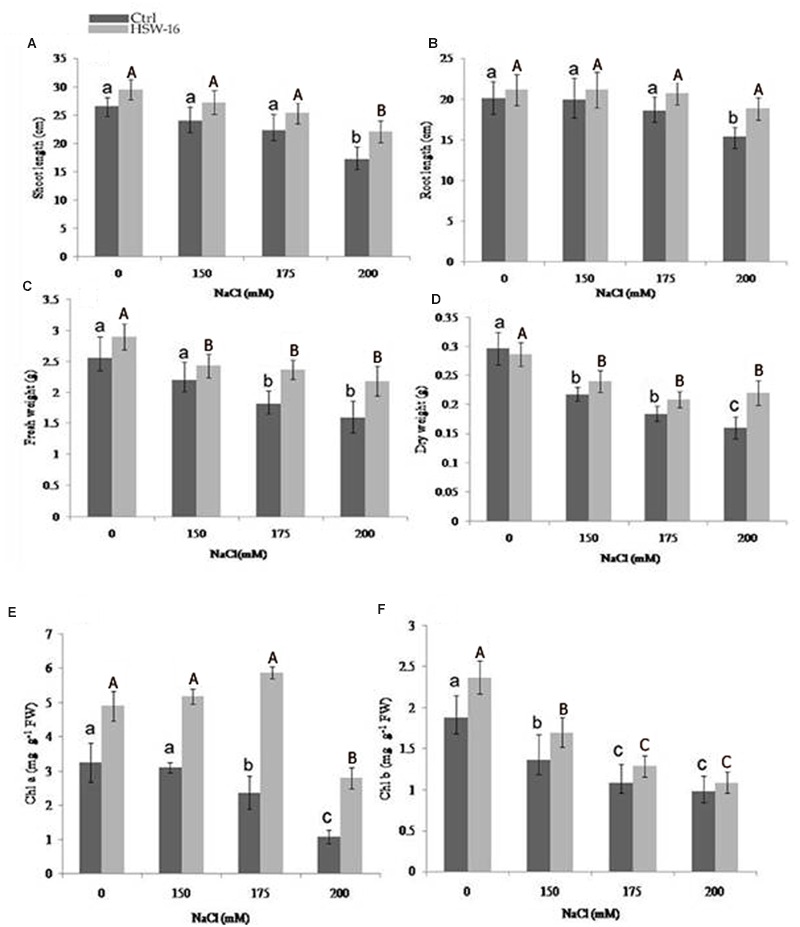
Effect of inoculation with B. licheniformis HSW-16 on plant biomass and chlorophyll content under different salinity conditions (0 mM, 150 mM, 175 mM, 200 mM NaCl). (A) Shoot length, (B) root length, (C) fresh weight, (D) dry weight, (E) chlorophyll a, and (F) chlorophyll b. Small letters on the bar in each treatment indicate significant difference (p < 0.05) among control, whereas capital letters indicate significant difference among the bacterial treatment. Dark and light gray columns represent the control (Ctrl) and HSW-16 inoculated plants, respectively.